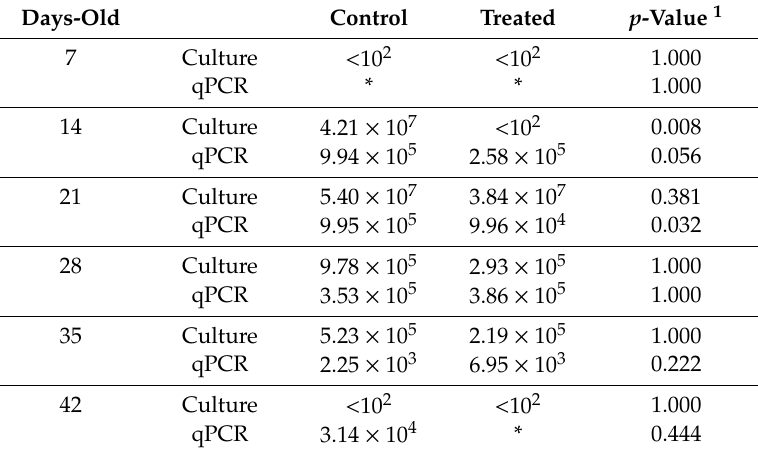
Table 2. Results of culture (CFU / g) and qPCR (genome equivalent / g) in 7-day-old challenged chickens. Days-Old